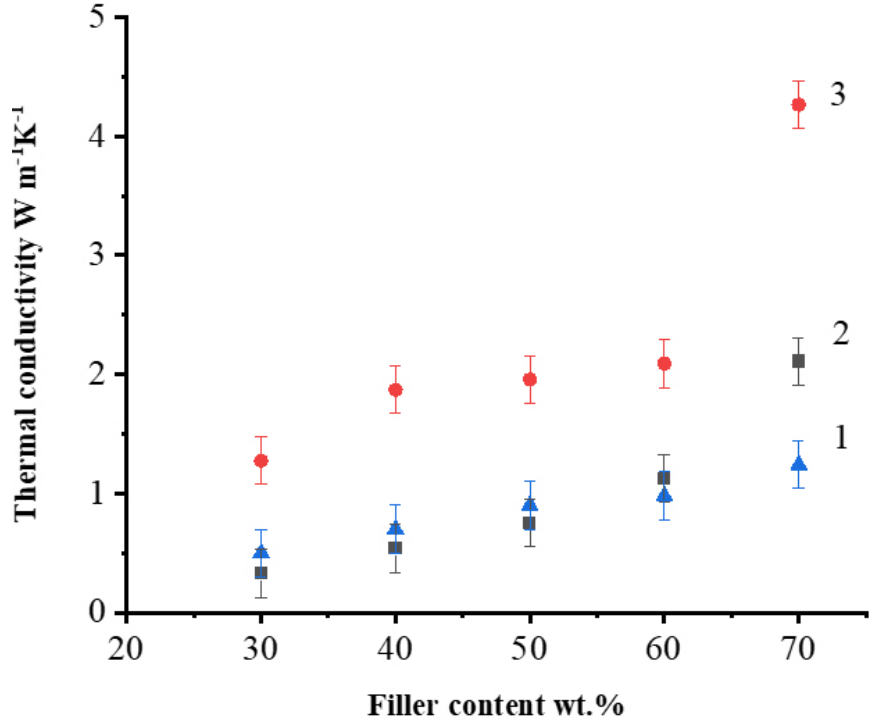
Figure 7. Thermal conductivity as function of filler content of unfilled PSU and PSU-based composite filled with EG ( 1 ); AG ( 2 ) and NG ( 3 ) at 25 °C.